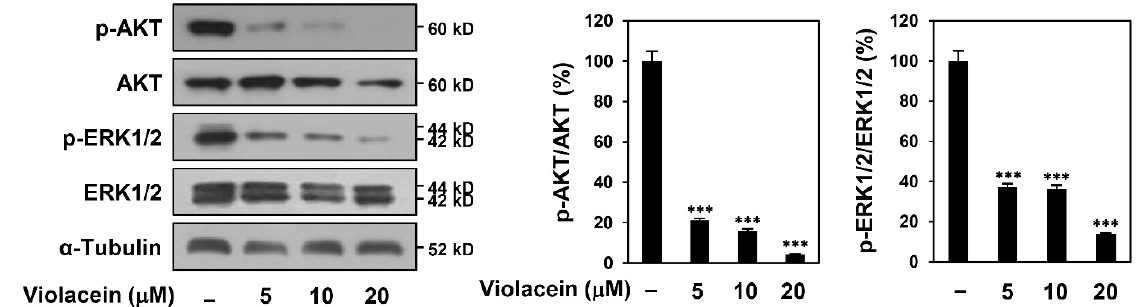
Figure 4. Violacein downregulates AKT and ERK signaling in Huh7 HCC cells. The cells were treated with violacein (5, 10, and 20 µM) for 1 h. Protein levels were detected by Western blot analysis using specific antibodies and were further quantified by densitometry. α –tubulin levels were used as an internal control. ∗∗∗ p < 0.001 vs. the control.